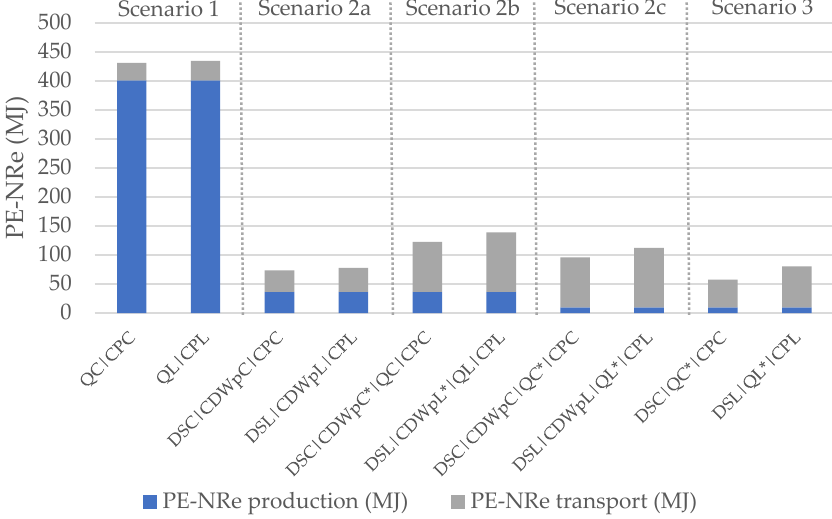
Figure 5. PE-NRe for production and transport of 1 tonne of aggregates.